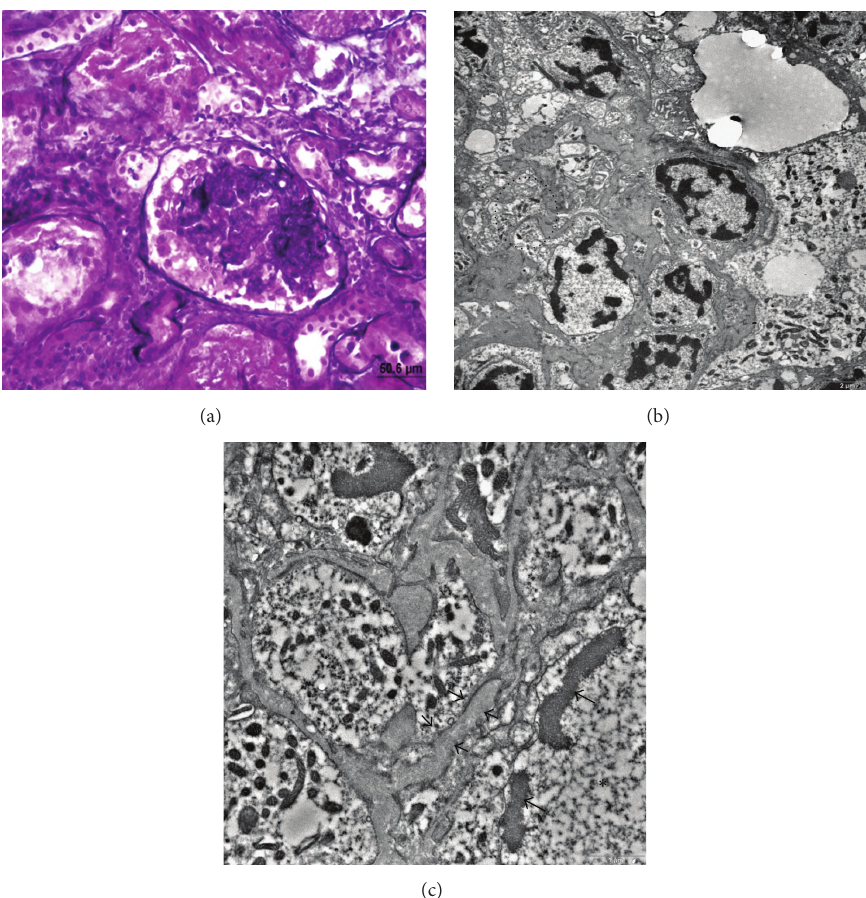
Figure 2: (a) Light microscopy shows wrinkling and collapse of the glomerular basement membranes accompanied by hypertrophied and hyperplastic podocytes forming pseudocrescents (Jones’ methenamine silver stain, × 400). (b) Electron microscopy shows diffuse swelling in the endothelial layer and podocytes with electron-lucent transport vesicles (circle), diffuse foot process effacement, and wrinkling, irregular thinning, and thickening of the glomerular basement membranes (Electromicrograph, bar = 2 𝜇 m). (c) At higher magnification, swollen podocytes with increased organelles, protein resorption droplets (long arrows), and a disrupted actin cytoskeleton (asterisk). The glomerular basement membranes had a radiolucent fibrillary appearance (short arrows), and the lamina densa had disappeared or was disrupted in many areas in the glomerular basement membrane (Electromicrograph, bar = 1 𝜇